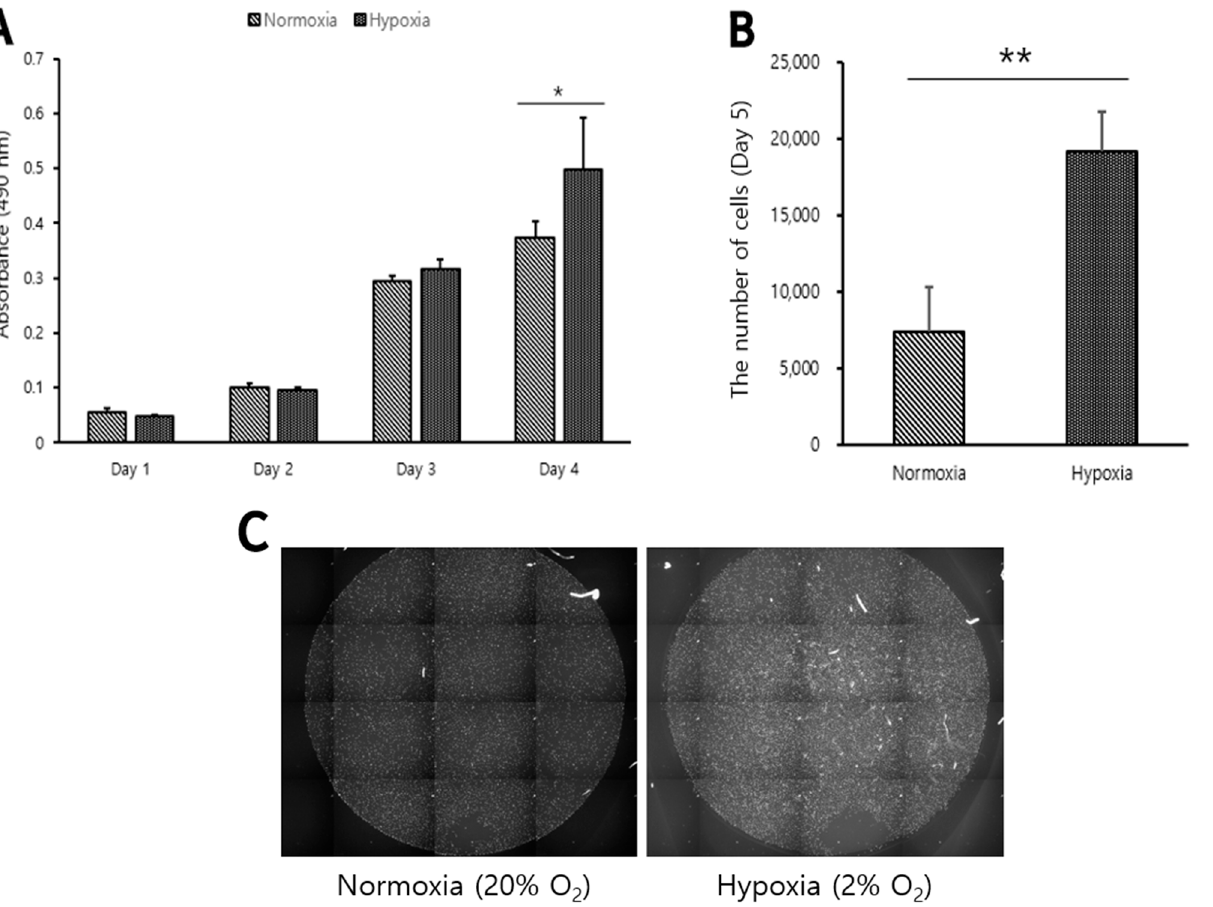
Figure 1. Proliferation of Belgian Blue myosatellite cells under normoxia (20% O 2 ) or hypoxia (2% O 2 ). ( A ) is quantitative assessment of cell proliferation of Belgian Blue myoblasts cultured on 1, 2, 3 and 4 days under hypoxia ( ) or normoxia ( ) in a 96-well plate. ( B ) is the number of Belgian Blue myoblasts cultured for 5 days in a multiplate under hypoxia or normoxia. ( C ) is the representative image showing Belgian Blue myoblasts cultured for 5 days and cell nuclei stained with Hoechst. The Belgian Blue myosatellite cells were proliferated by culturing in GM. Experiments were performed in triplicate and repeated three times with similar results and values are mean ± standard deviation. Asterisk means significant difference (* p < 0.05, ** p < 0.01).